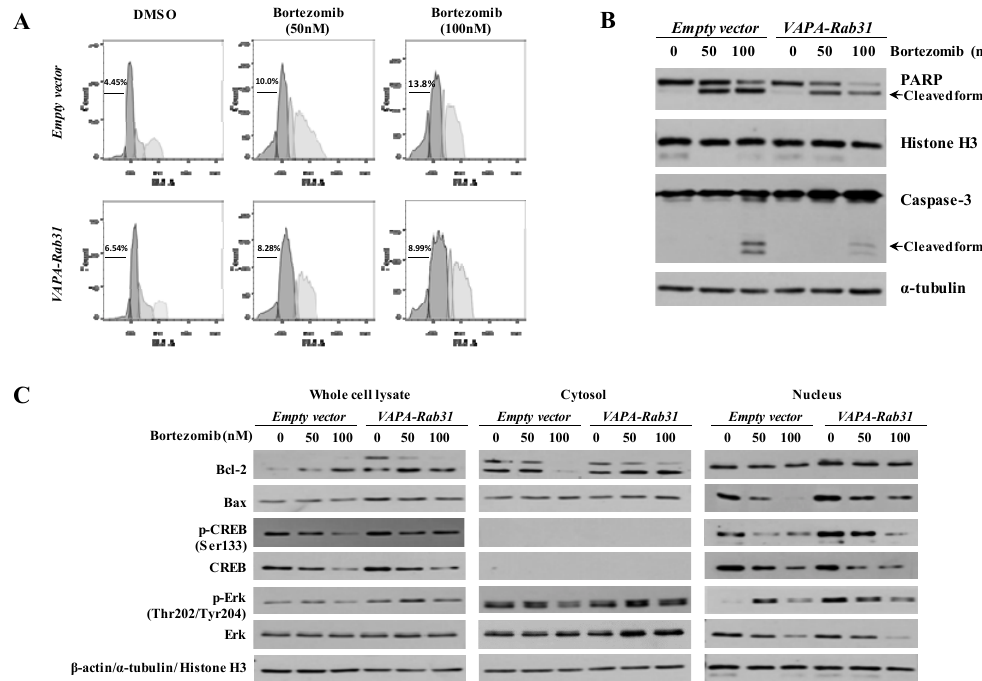
Figure 3. The VAPA-Rab31 fusion gene induced the resistance to apoptosis. ( A ) Cell cycle was analyzed in 48 h after bortezomib treatment at the indicated concentration. The percentage of cells in sub-G1 phase (%) was indicated. ( B ) Cleavage of PARP and Caspase-3 were examined as the apoptotic markers by western blotting at 48 h after bortezomib treatment. ( C ) Protein expression was examined in whole cell lysates, cytosolic fractions, and nuclear fractions. Phosphorylated CREB and CREB were highly expressed in the nuclear fractions and did not detected in the cytosolic fractions. β -actin, α -tubulin, and histone H3 were used as loading control for whole cell lysates, cytosolic fraction, and nuclear fraction, respectively.